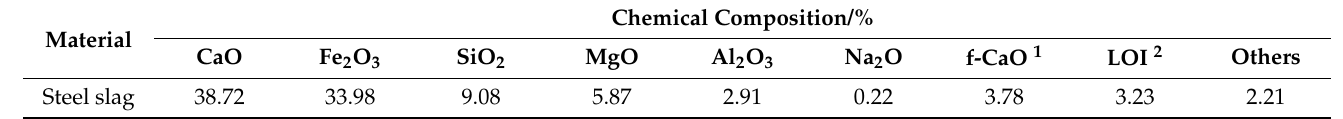
Table 1. Chemical composition of the steel slag. Chemical